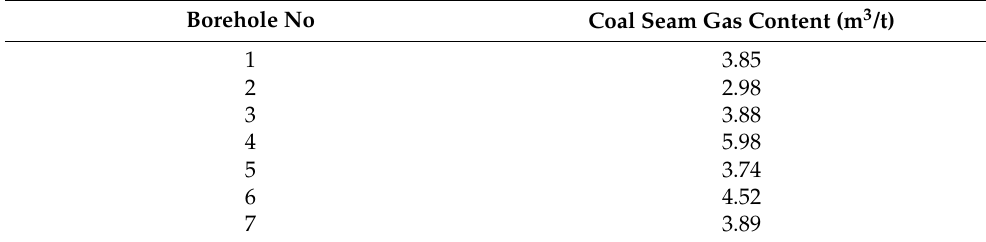
Table 5. Residual gas content in 2# coal seam.